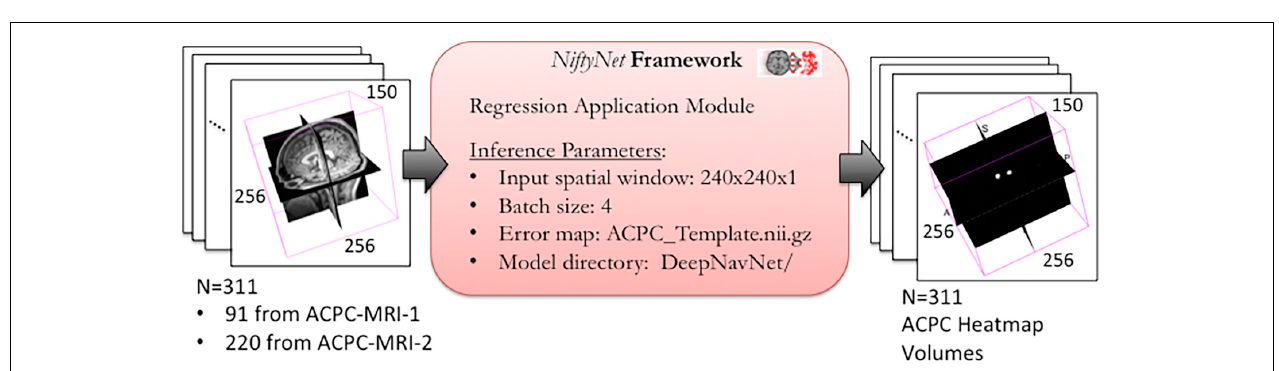
FIGURE 2 | Training and validation of DeepNavNet model using NiftyNet framework. Each input data volume is 256 × 256 × 150 voxels with 1 mm 3 × 1 mm 3 × 1 mm 3 resolution. Key parameters from a customized NiftyNet configuration file are displayed on the right. These parameters were used to create DeepNavNet Model #1 (see Table 1 ).